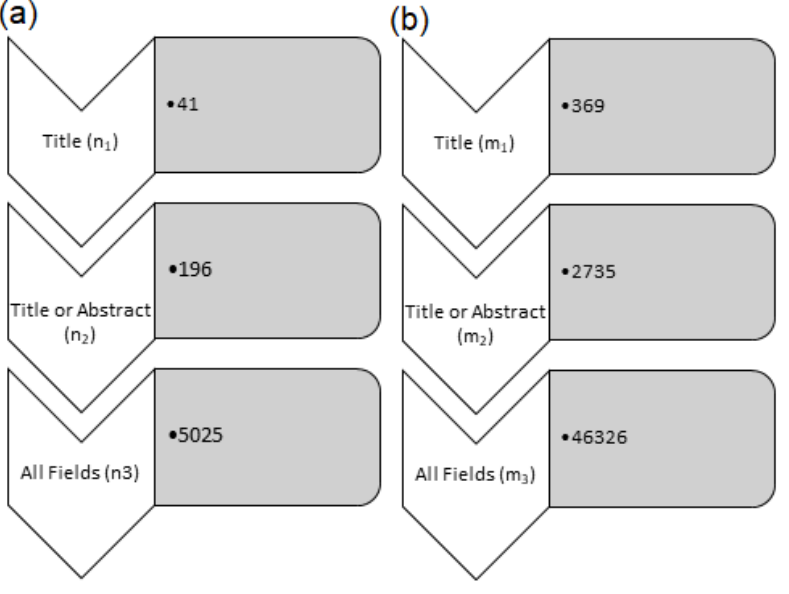
Figure 3. Flow chart of the article selection, i.e., ( a ) review and ( b ) research articles used in the preparation of the present review article.